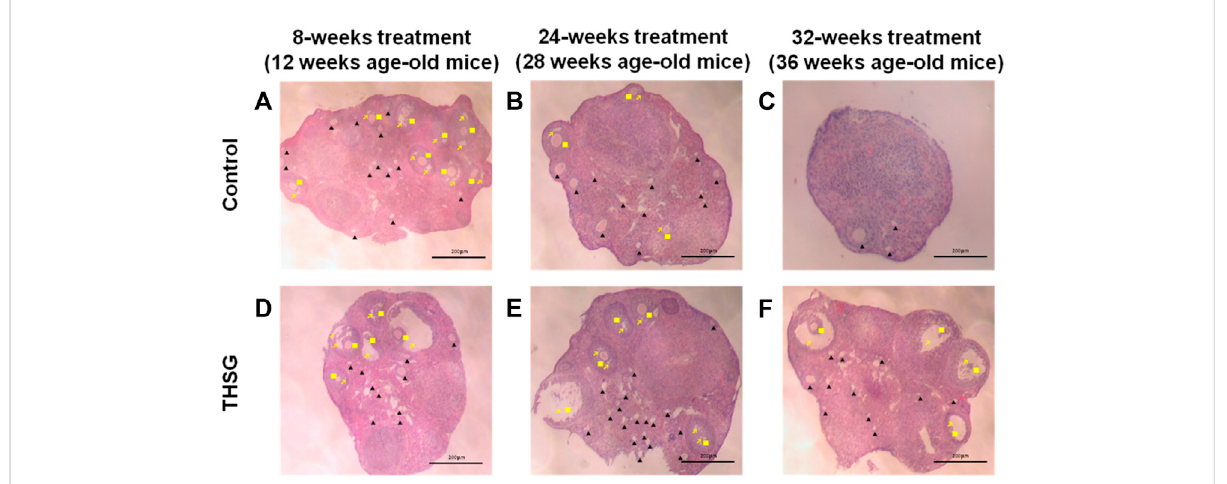
FIGURE 3 THSG increases preantral and antral follicles in aging young mice. The ovaries of 8-weeks, 24-weeks, and 32-weeks mice fed with or without THSG were collected and performed hematoxylin and eosin stain in control groups (A – C) and THSG-fed groups (D – F) . Different follicular stages were observed: primordial and preantral follicle (black triangle), antral follicle (yellow square) and antral spaces (yellow arrowhead).